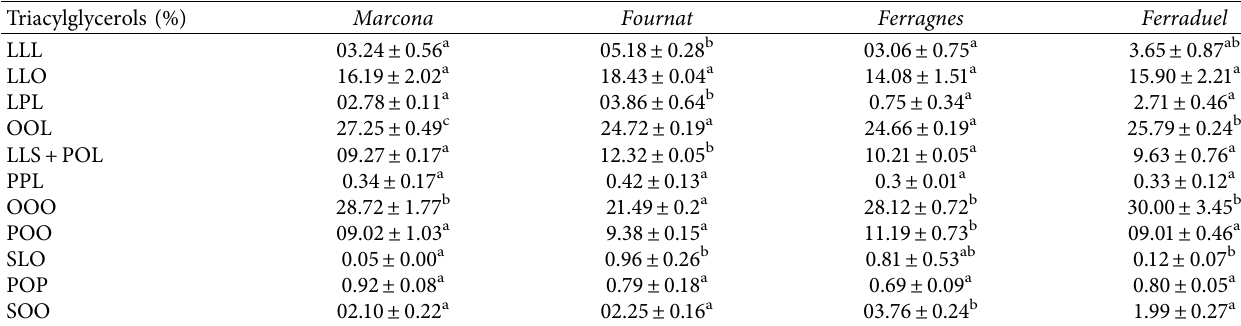
Table 6: Triacylglycerol molecular species of four almond oil varieties produced in eastern Morocco. Triacylglycerols (%) Marcona Fournat